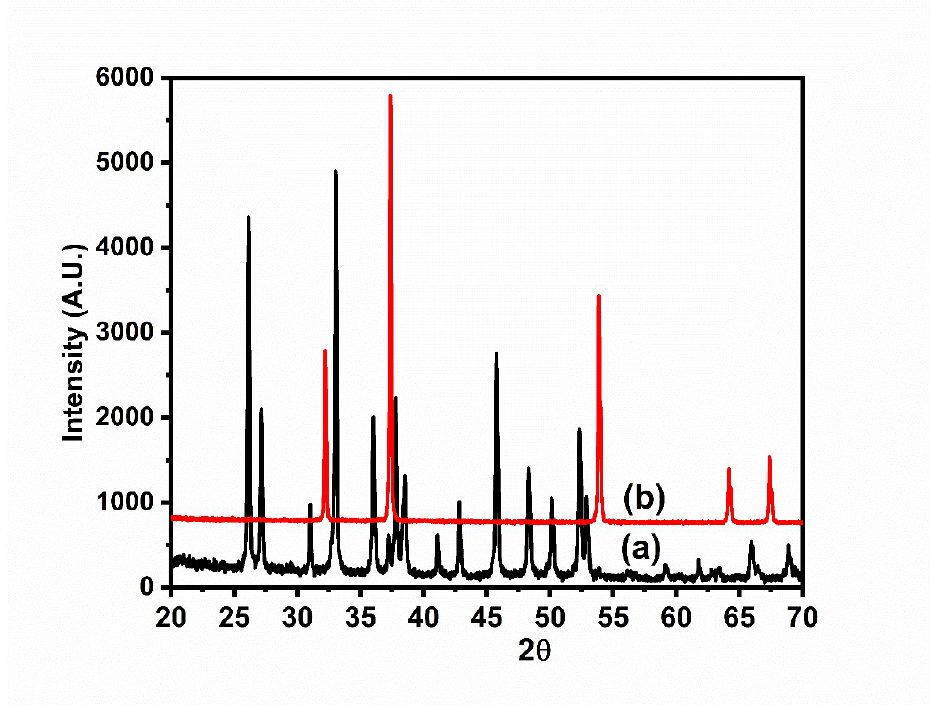
Figure 1. XRD patterns for the ( a ) natural GRS shell and ( b ) calcined GRS shell at 900 °C.